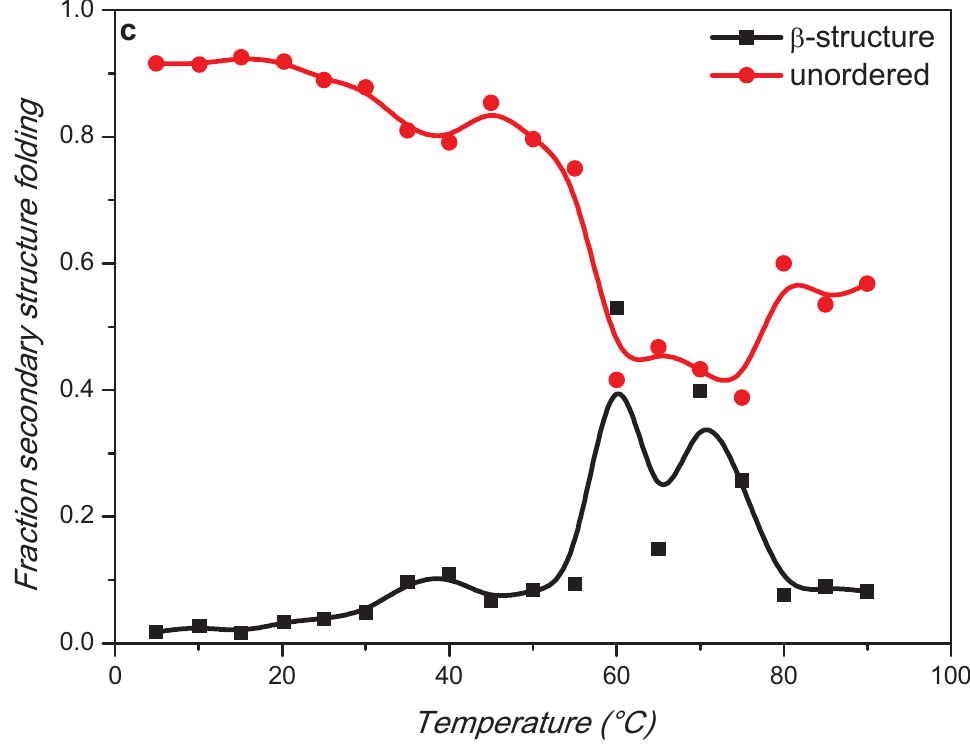
Figure 5. Secondary structure (cid:3)-strand and unorder components melting curves of (cid:2)-synuclein alone ( a ) or in presence of 10 mM ( b ) or 100 mM ( c )